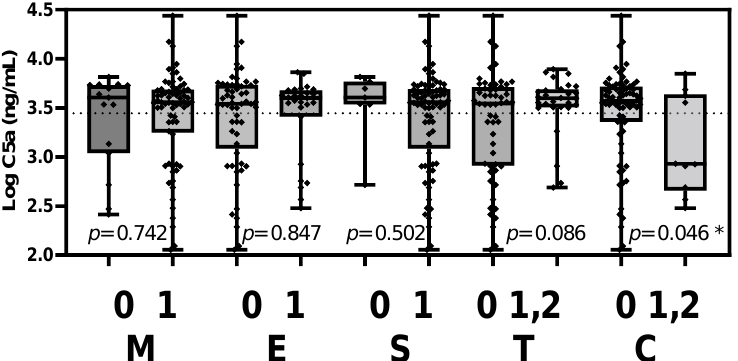
Figure 5. Plasma C5a levels stratified according to the Oxford MEST-C criteria. Plasma C5a level was elevated in patients with crescents ( p = 0.046). M, mesangial hypercellularity; E, endocapillary hypercellularity; S, segmental glomerulosclerosis; T, tubular atrophy/interstitial fibrosis; C, cellular or fibrocellular crescents. * p < 0.05. 3.5. Multivariable Logistical Regression Analyses of Tubular Atrophy/Interstitial Fibrosis As shown in Table 4, two models of multivariate logistic regression analyses both revealed that a higher factor Ba level was independently associated with the Oxford T scores after being adjusted according to age, gender and other risk factors including dia- betes, UPCR, and usage of ACEI/ARB. Table 4. Associations between the plasma factor Ba level with tubular atrophy/interstitial fibrosis (the Oxford T scores). Independent Variables in Model (Dependent Variable: T Scores)